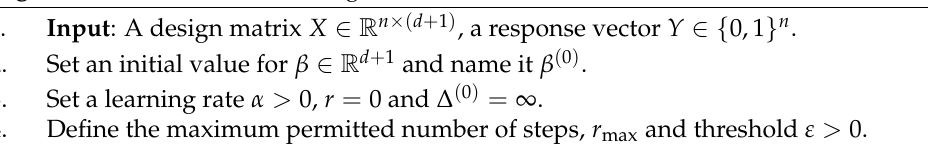
Algorithm 2 Gradient descent